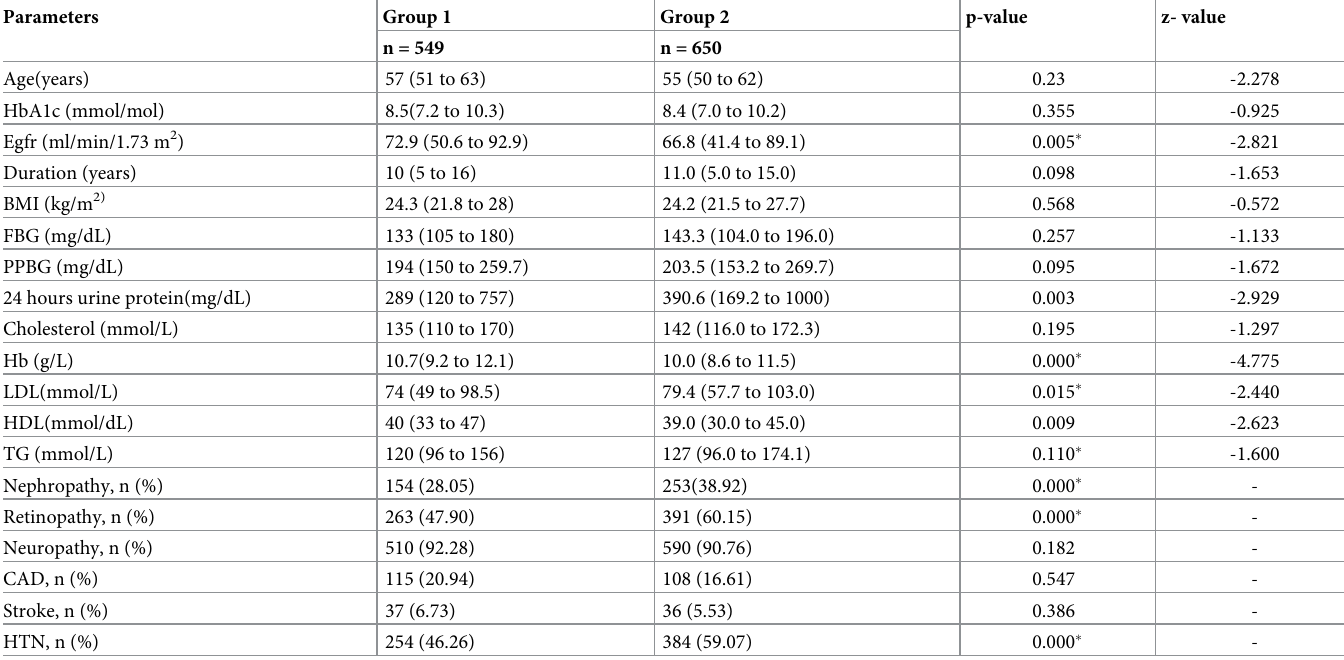
Data represented as median (inter-quartile range) unless specified and two group comparison was performed by Mann-Whitney test. Categorical variable are represented as n (%) and intergroup comparison was performed by Chi-square test.